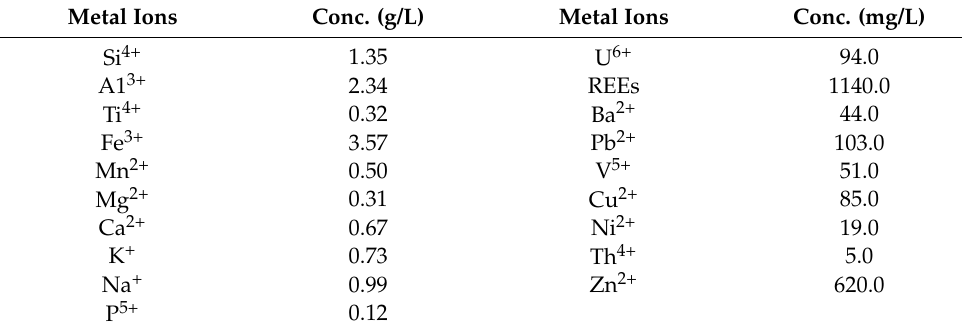
Table 6. Chemical investigation of metal ions in the leach liquor.